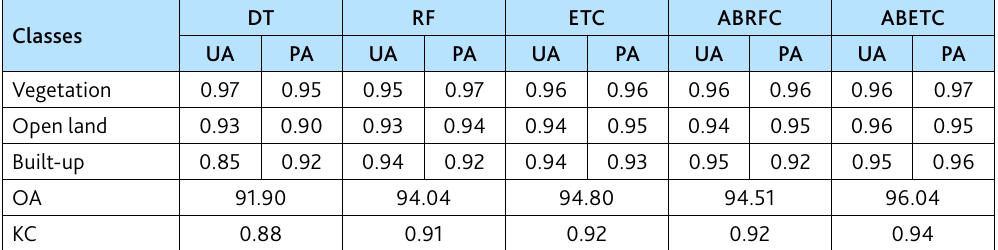
Table 4. Accuracy Statistics comparison for DT, RF, ETC, ABRFC, and ABETC Classifiers for Vadodara